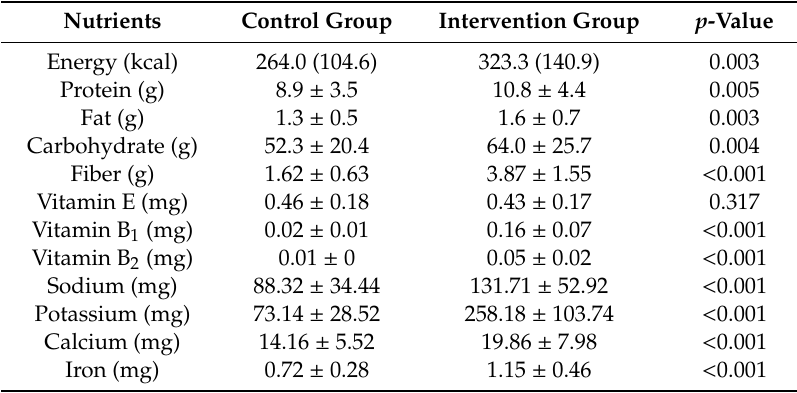
Table 3. Nutrients provided by the steamed breads daily (Mean ± SD).